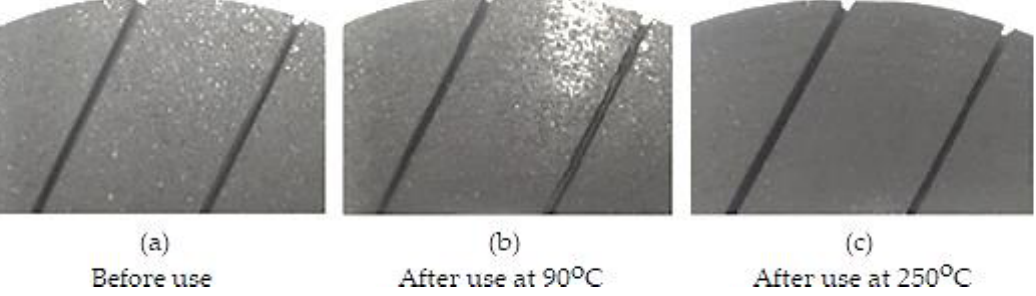
Figure 10. Pads friction material: ( a ) new condition without bedding (0%); ( b ) about 25% bedding; ( c ) approximately 95% bedding.